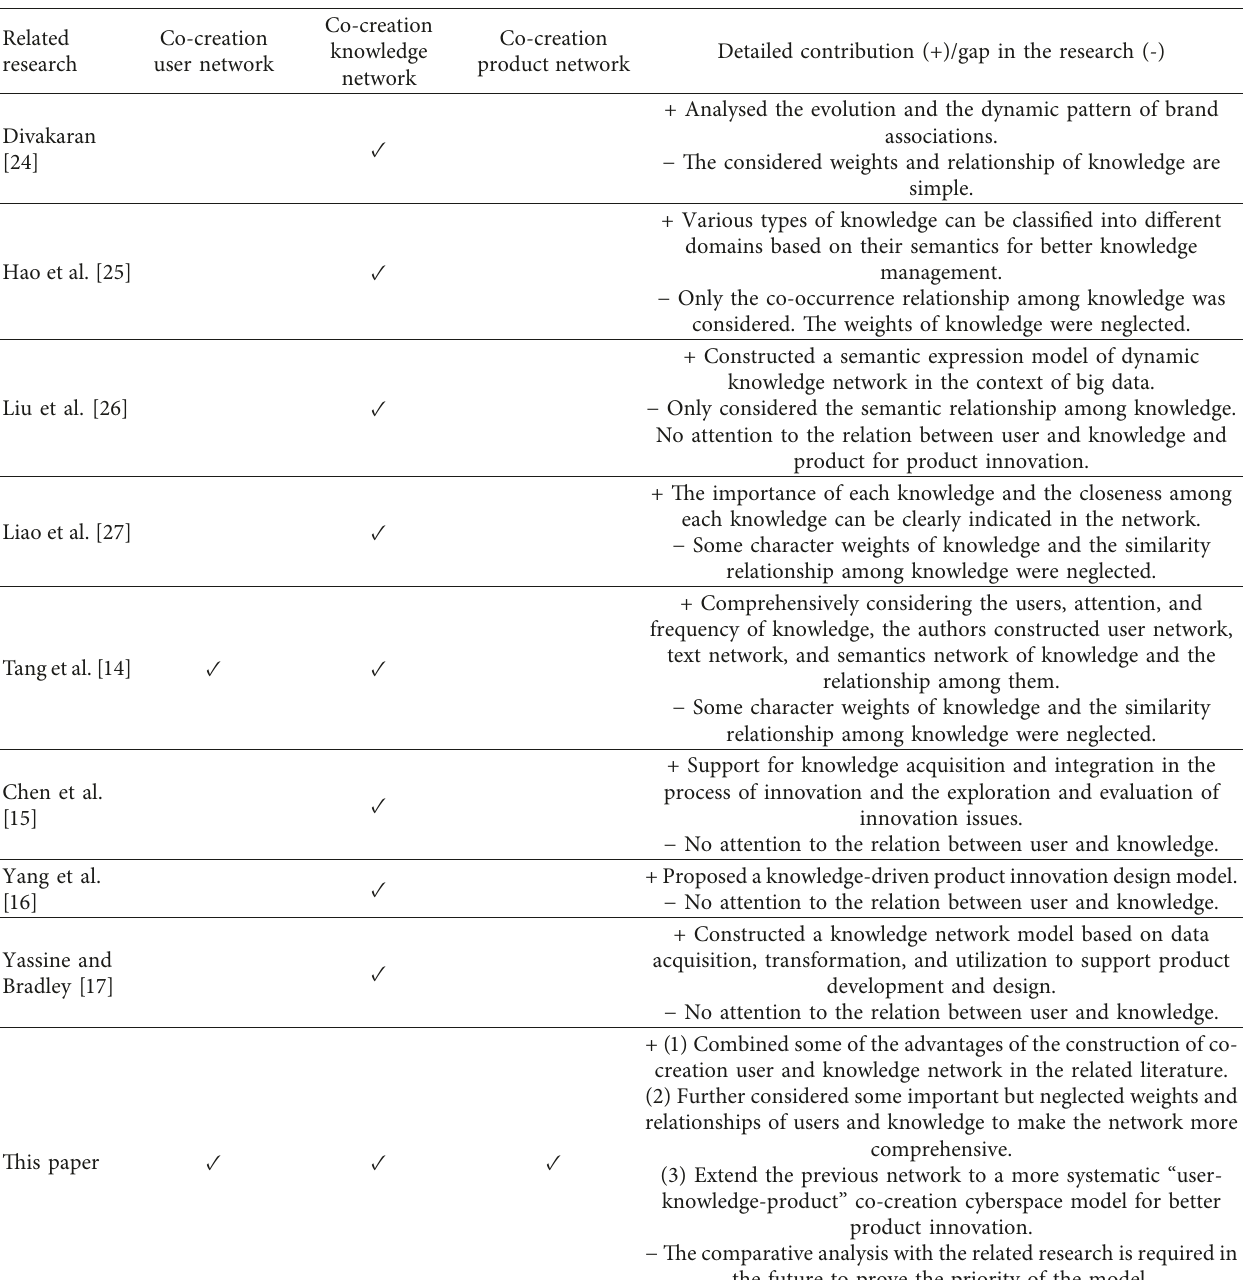
Table 1: Previous research